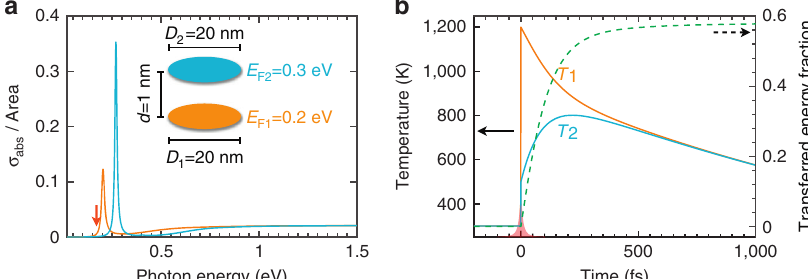
Fig. 4 Ultrafast radiative heat transfer induced by optical pumping. a Normalized absorption cross-sections σ abs of two graphene nanodisks (20 nm diameter, d = 1 nm separation) at the same initial temperature of 300 K but doped with different Fermi energies (see inset). b Time evolution of the electron temperatures T 1 and T 2 ( left vertical scale, solid curves ) and transferred energy fraction ( right vertical scale, dashed curve ) after optical pumping (150 mJ m − 2 light fl uence, 0.17 eV photon energy, as indicated by the red arrow of a